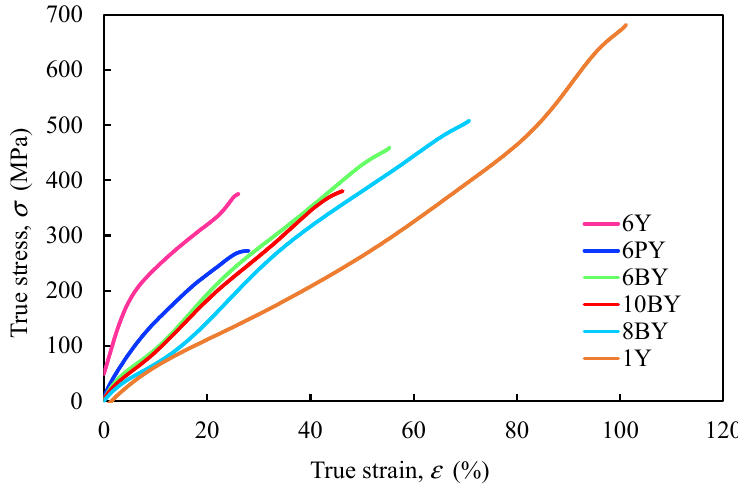
Figure 10. Quantitative analysis of relative resistances error as a function of the number of PVA filaments.